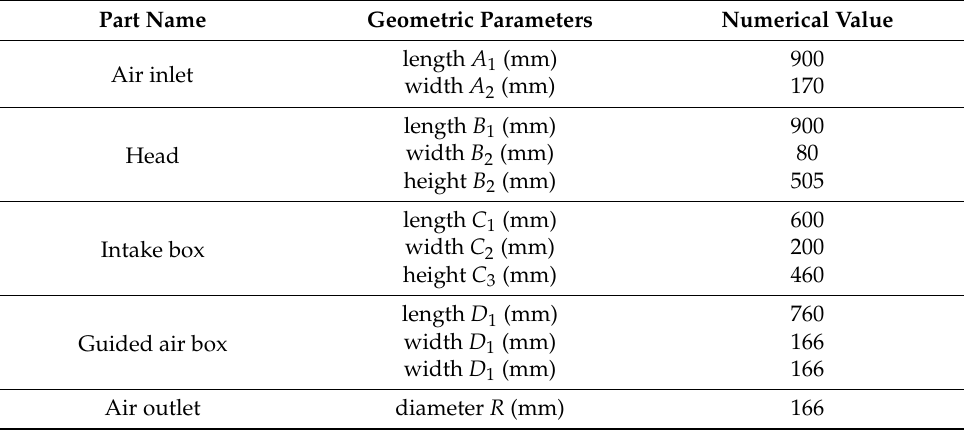
Table 1. Description of the key parameters of the integrated stove air duct system.